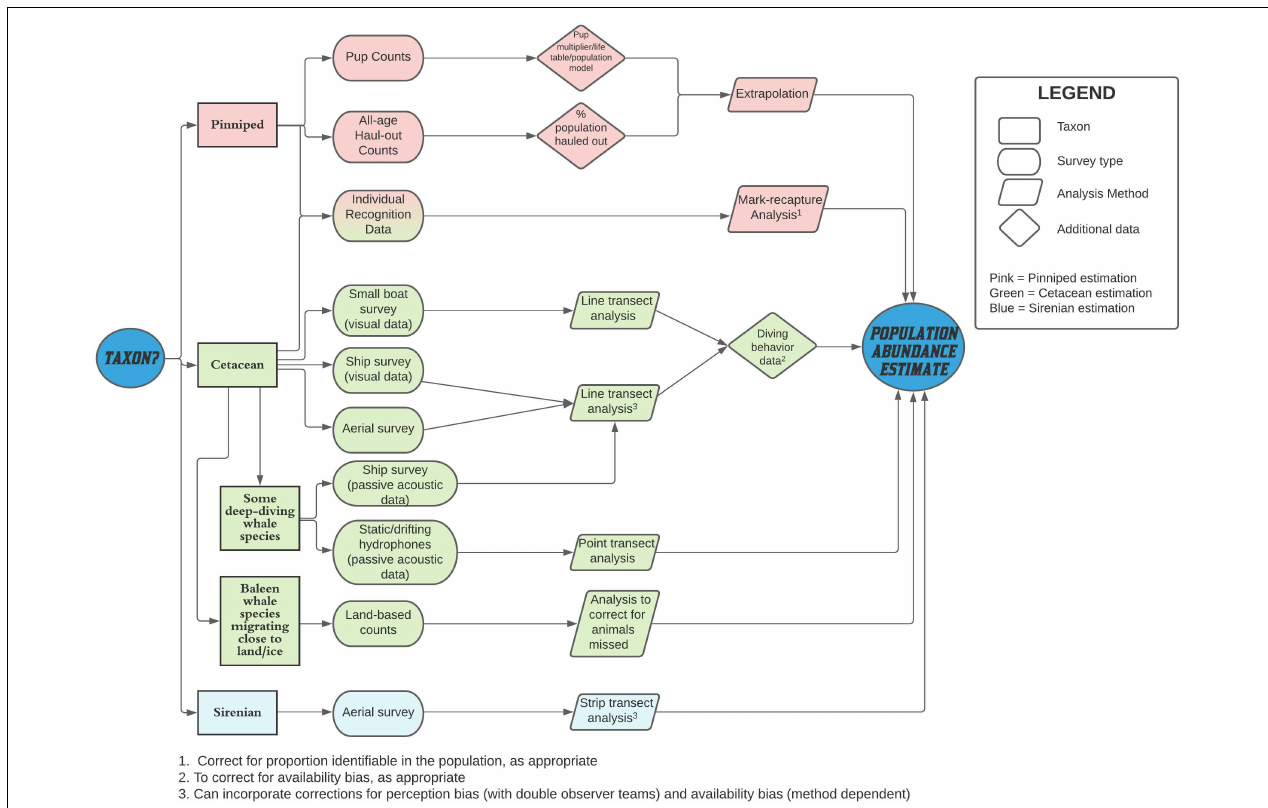
FIGURE 2 | Simplified schematic of the flow of information and activity when estimating the abundance of marine mammal